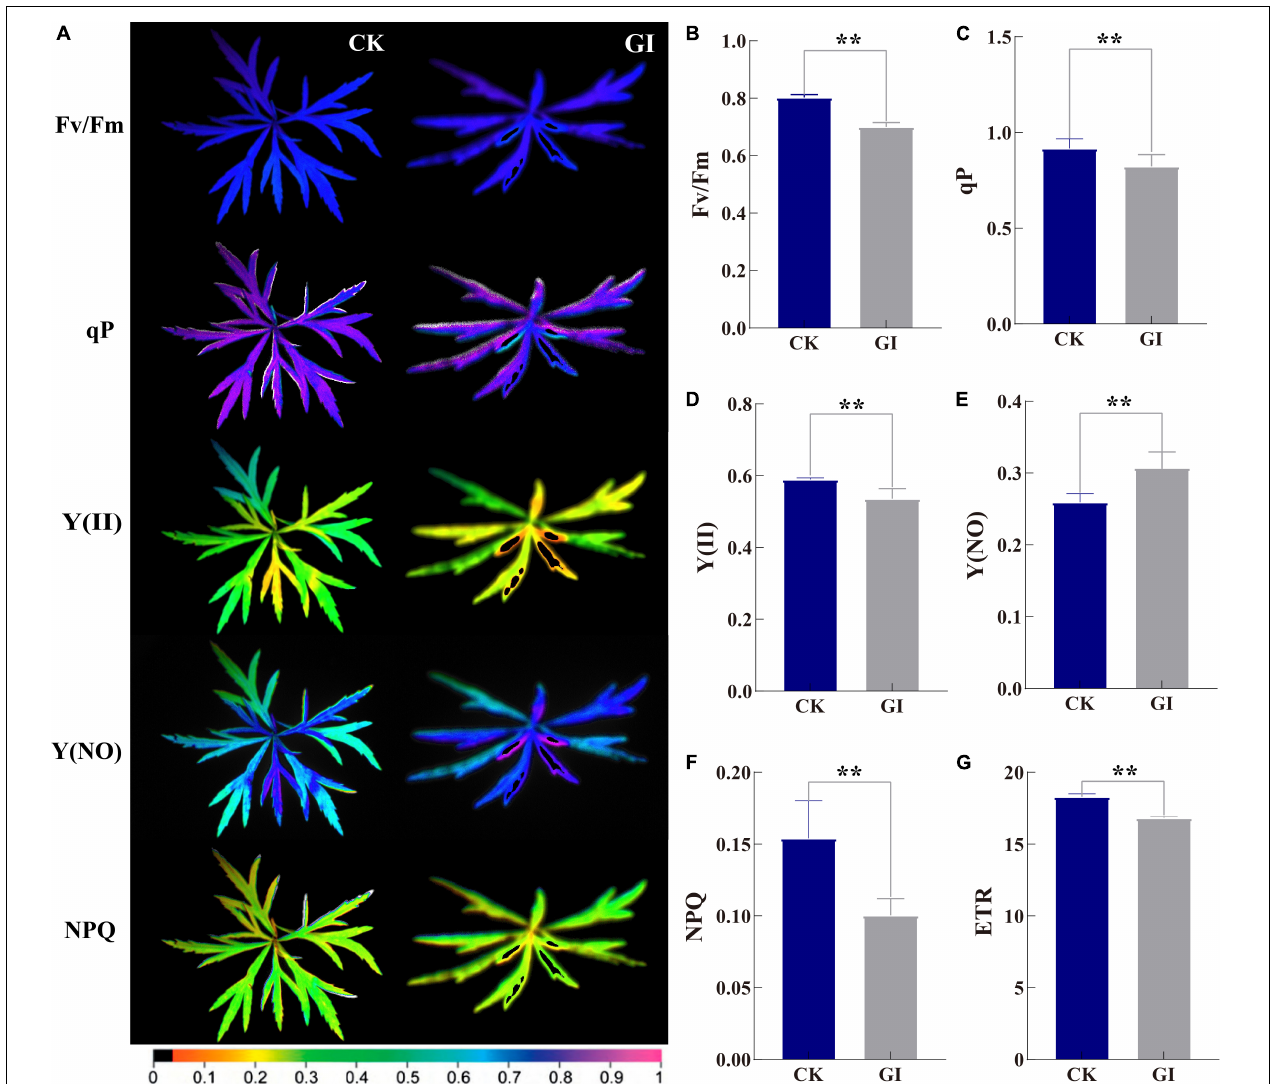
FIGURE 5 | Chlorophyll fluorescence imaging of G. artemisiae on A. selengensis . Images (A) and data of (B) maximal quantum yield of PSII photochemistry (Fv/Fm), (C) photochemical quenching (qP), (D) effective PSII quantum yield [Y(II)], (E) quantum yield of non-regulated energy dissipation [Y(NO)], (F) non-photochemical quenching (NPQ) coefficient, and (G) electron transport rate (ETR) following infection by G. artemisiae . Mock-infected control leaf is shown for comparisons. The color scale at the bottom (A) indicates values from 0 (black) to 1 (pink). Values are means ± SE of three biological replicates (B–G) . Significant differences were calculated using the unpaired Student’s t -test (** P ≤